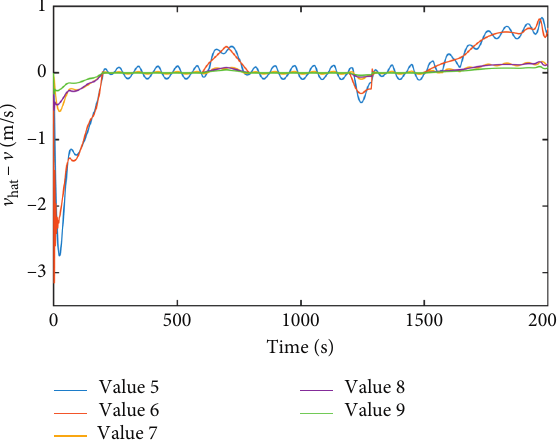
Figure 9: Velocity observer estimation error of the HST.